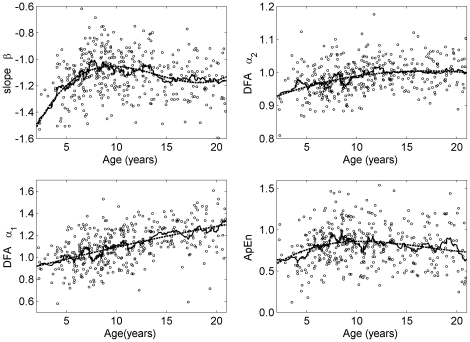
Course of the fractal and complexity measures during childhood and adolescence.Slope β – long-term fractal scaling properties, DFA α2 – intermediate-term fractal scaling properties, DFA α1 – short-term fractal scaling properties, ApEn - complexity. The dots represent 24 hour averages. Solid and dashed lines show moving average and the fitted polynomial model of order 3, respectively.